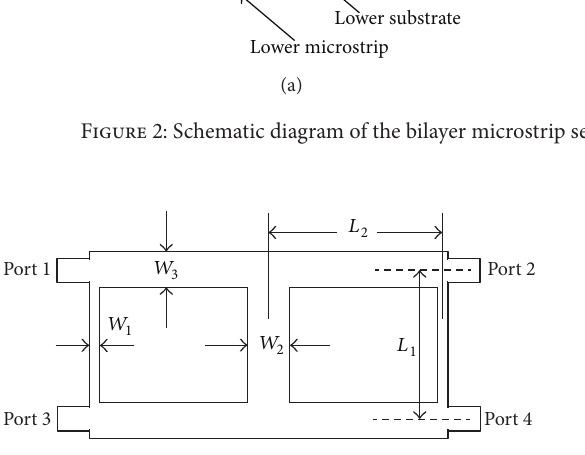
Figure 3: The upper circuit structure diagram of the three-branch line directional coupler, in which 𝑊 1 = 0.4 mm, 𝑊 2 = 3.5 mm, 𝑊 3 = = 16.5 mm, and 𝐿 = 11.3 3.5 mm, 𝐿 1 2